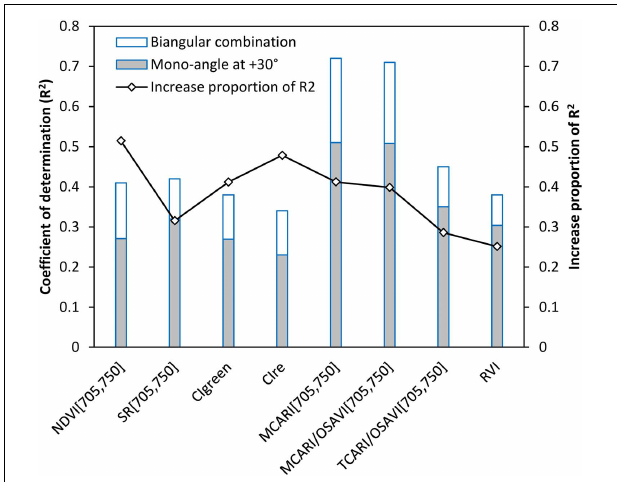
FIGURE 9 | Comparisons of R 2 values of relationships between biangular-combined vegetation indices (VIs) vs. canopy chlorophyll content and mono-angular VIs at +30 ◦ viewing angle vs. canopy chlorophyll